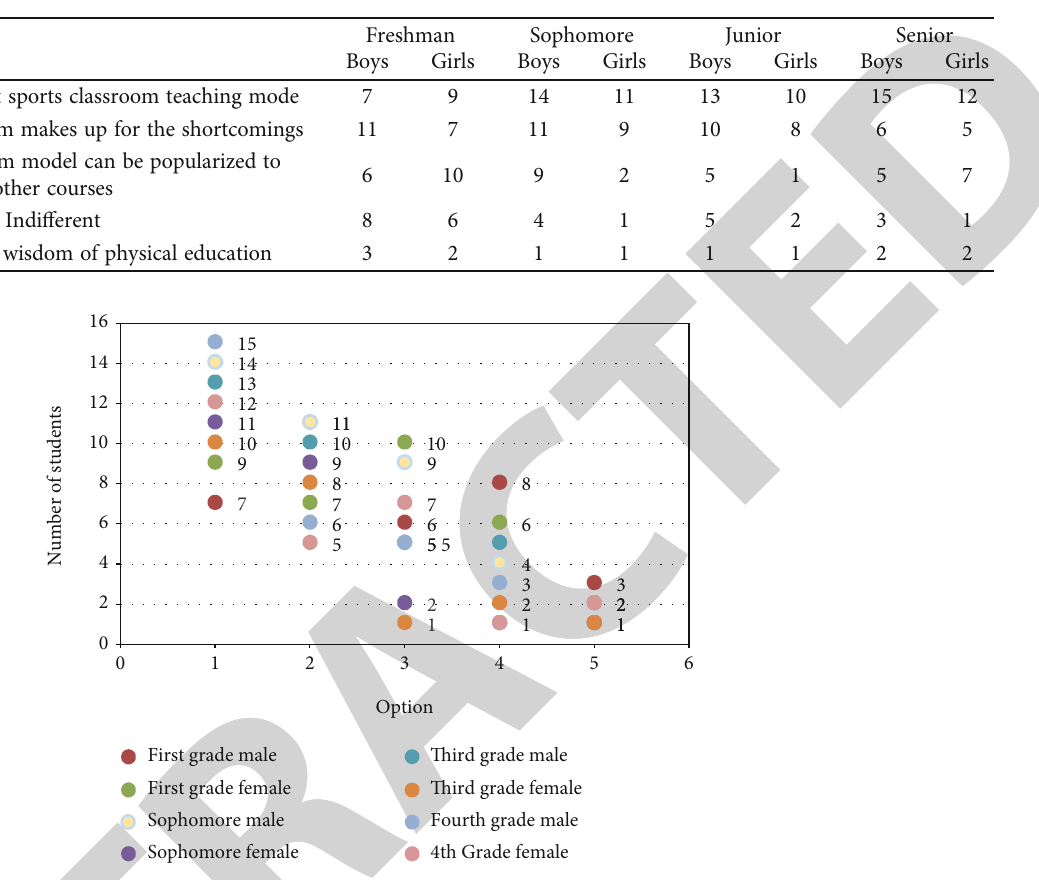
Table 4: Attitudes of students to the smart sports classroom teaching model.